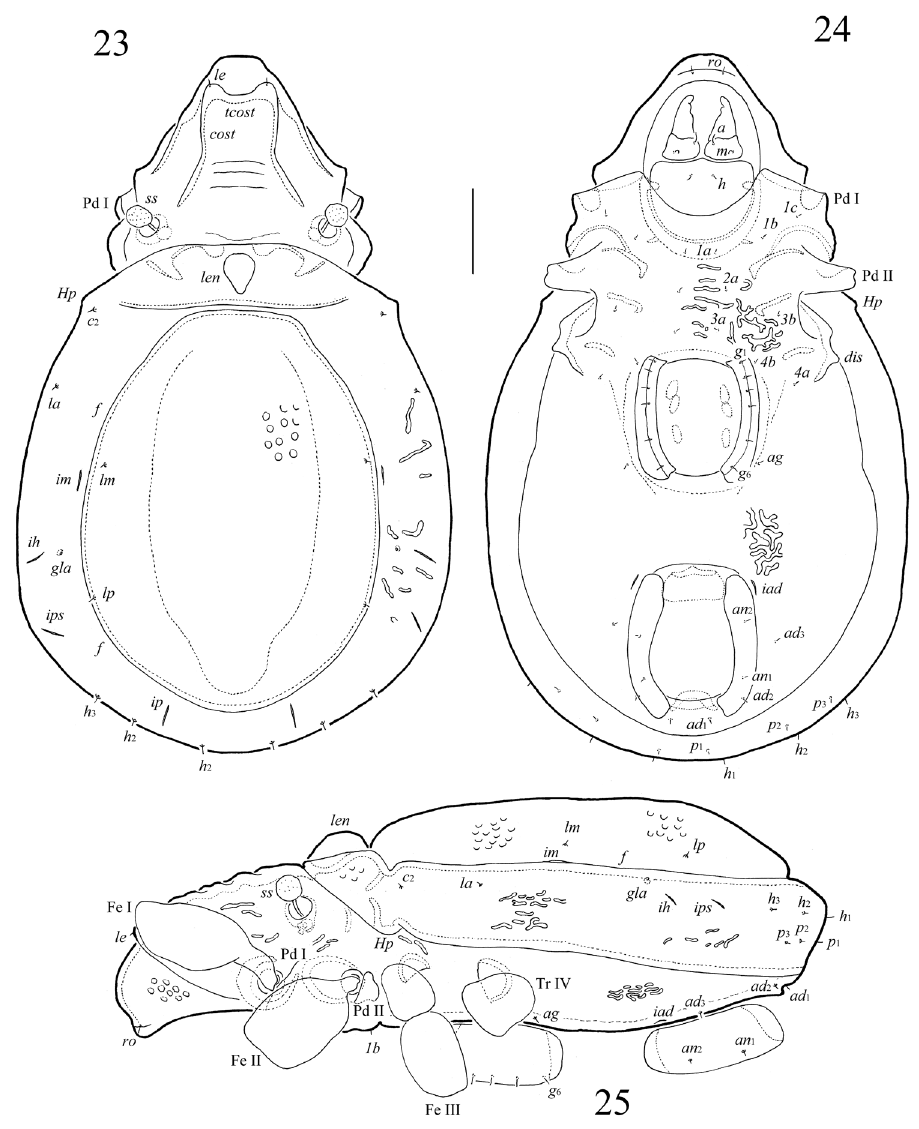
Figures 23–25. Scapheremaeus luxtoni sp. n., adult: 23 dorsal view 24 ventral view (legs not shown) 25 lateral view (gnathosoma and legs except basal parts not shown). Scale bar 50